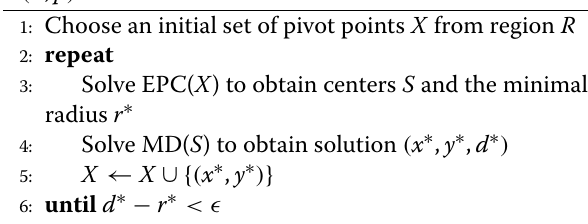
Algorithm 1 Iterative Algorithm for